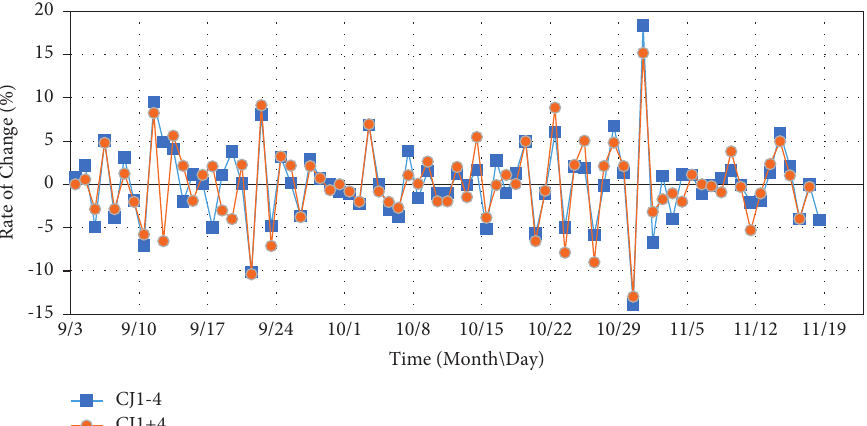
Figure 11: Rate of change of daily settlement (CJ1-4 and CJ1 +4).